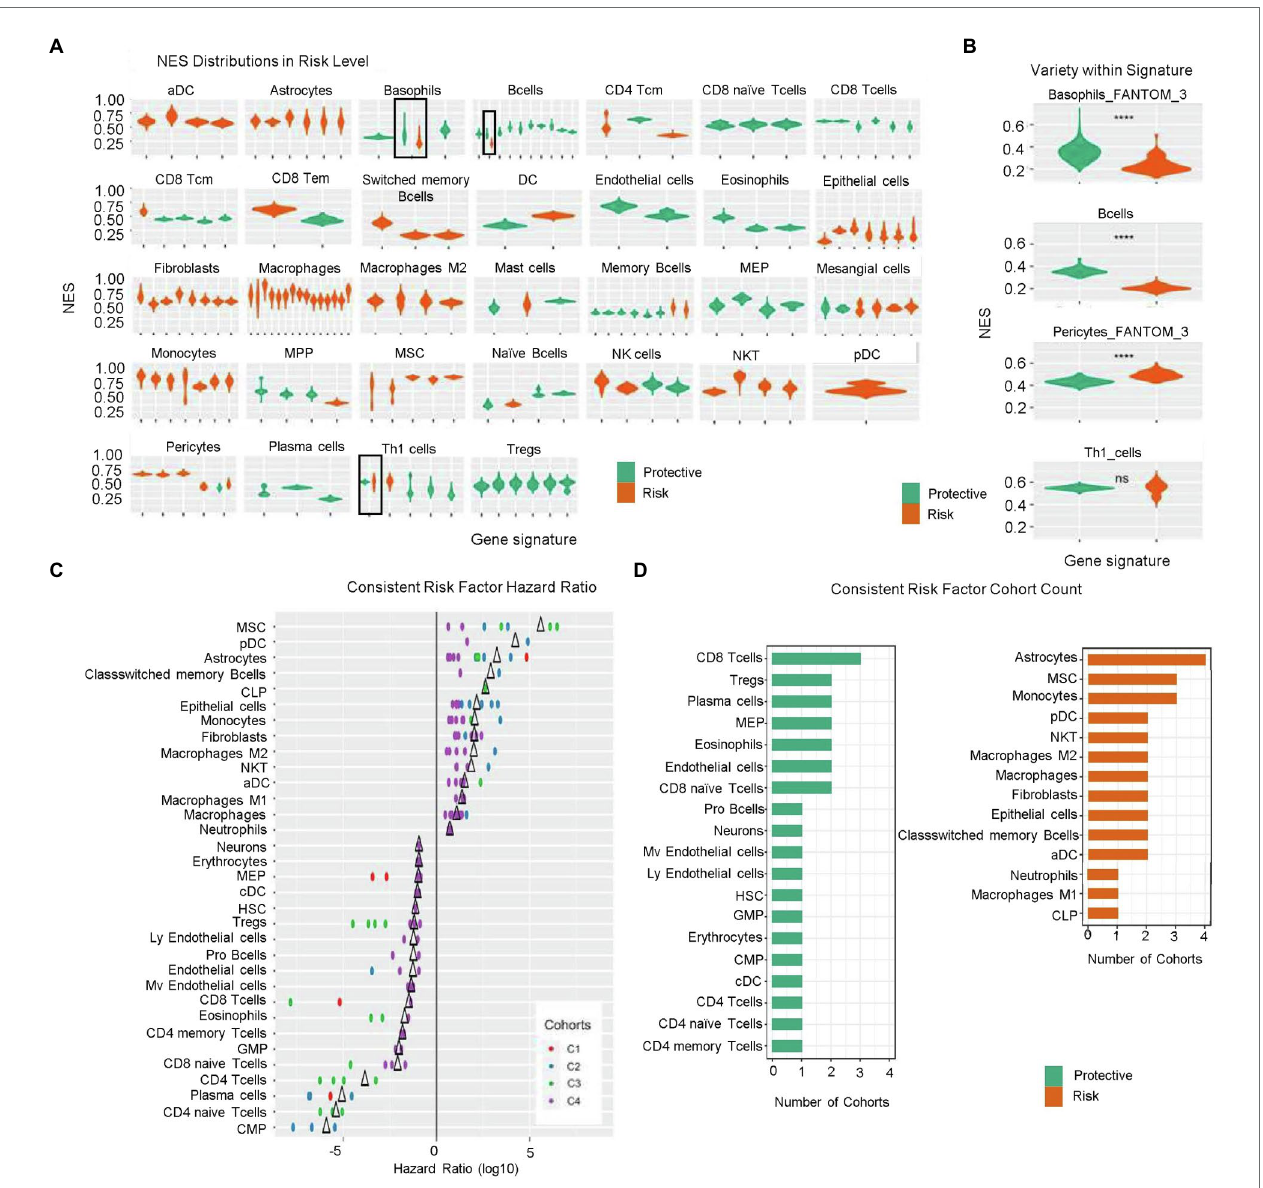
FIGURE 2 | Risk levels according to calculated NESs. (A) NES distribution of prognostic signatures as denoted by risk levels (risk factors, orange; protective factors, green). (B) Variety of NES distribution within signatures. ns, p > 0.05; and **** p ≤ 0.0001. (C) Hazard ratio of consistent risk factors (>1, risk factor; <1, protective factor; and ∆ , mean value). (D) Group count of consistent risk factors. NES, normalized enrichment score; NIR, negative immune response; ns, not significant; and PIR, positive immune